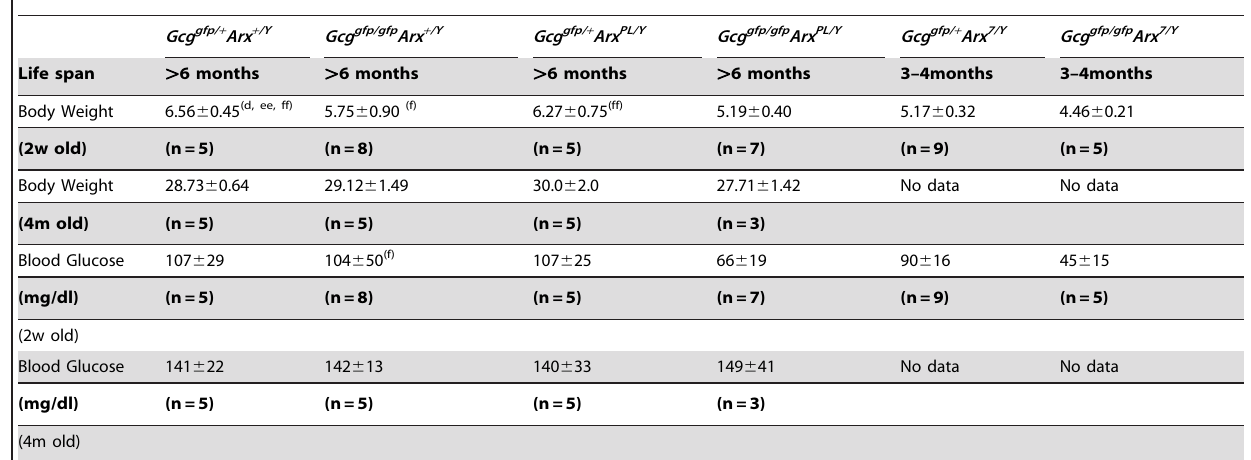
Table 1. Phenotype of the mutant mice.